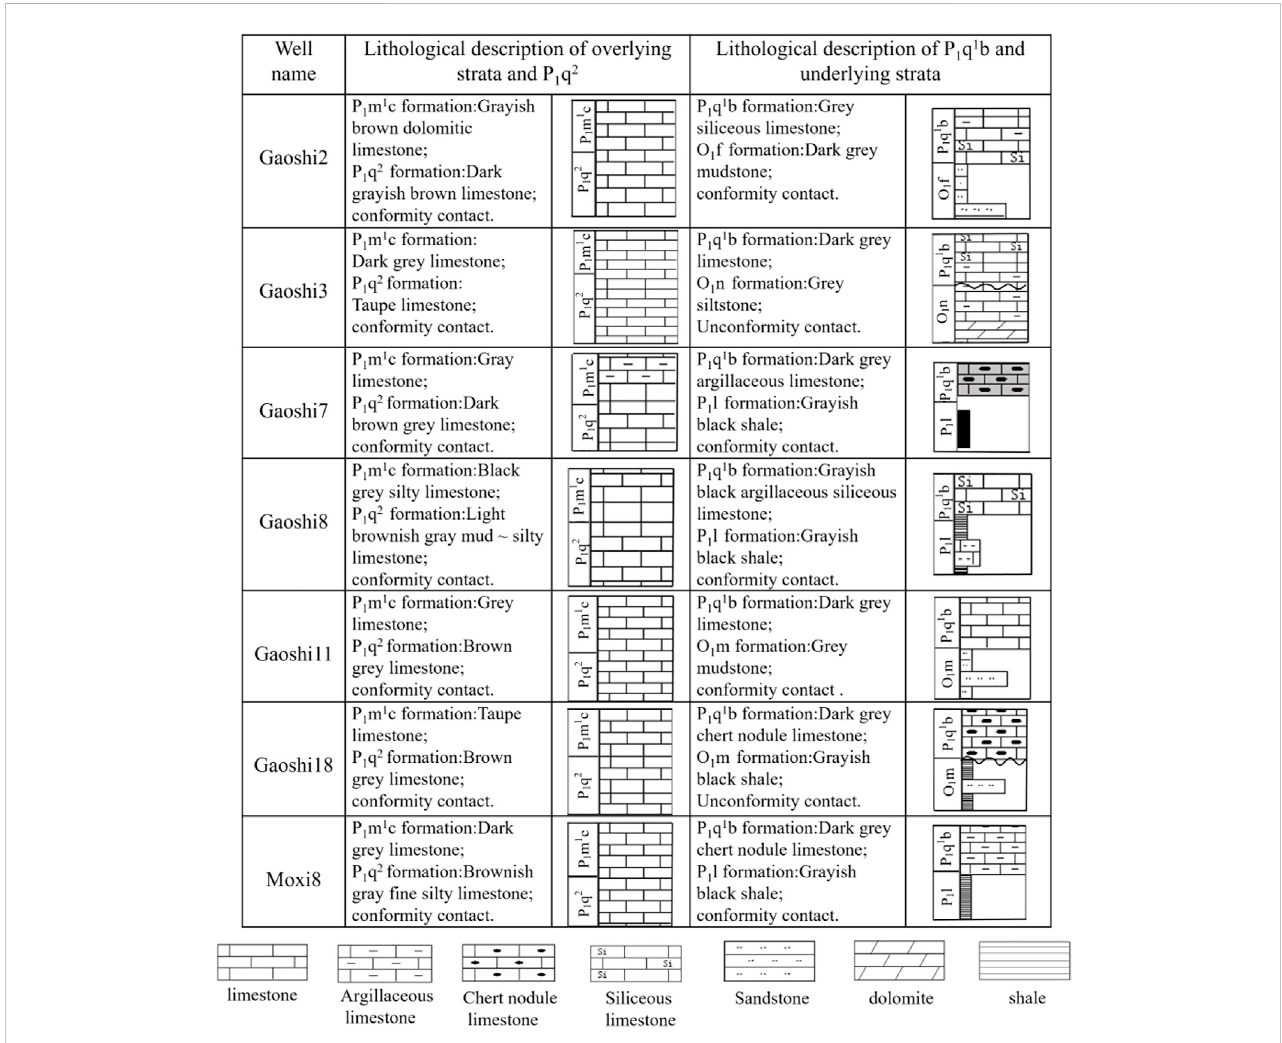
Lithological characteristics of underground Qixia Formation and surrounding rock in the study